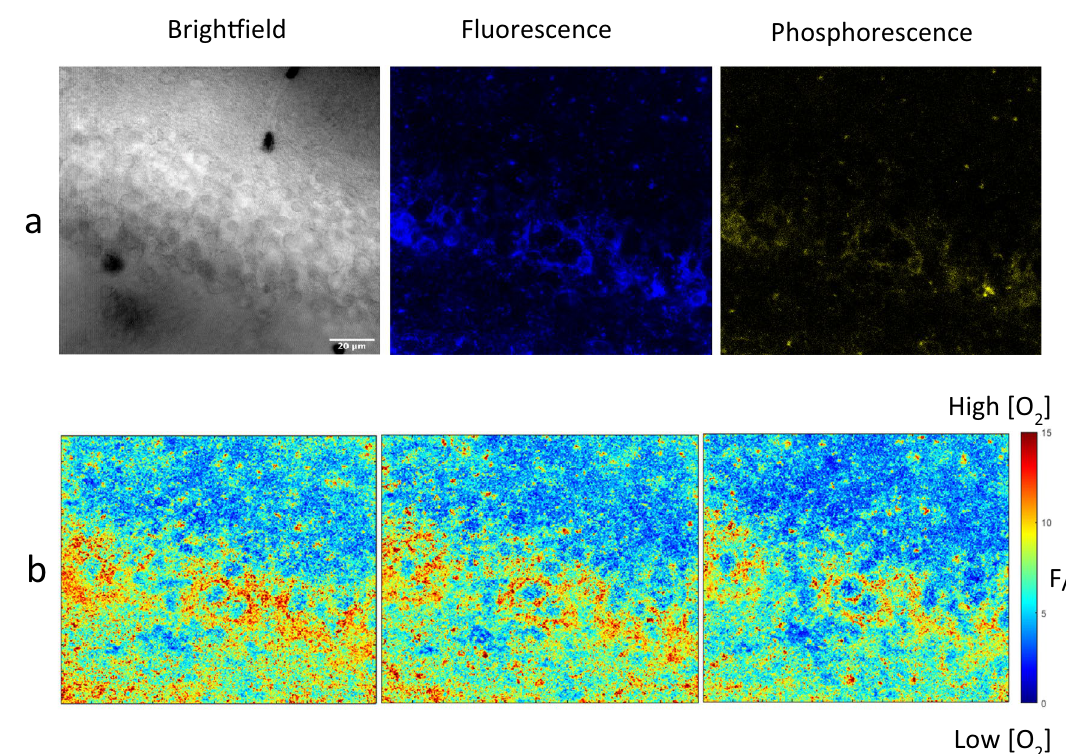
Figure 4. Brain slice imaging with O 2 NPs. ( a ) Brightfield, fluorescence, and phosphorescence emission of the hippocampus DGC layer. ( b ) Ratiometric imaging when the oxygen supply is off over time.